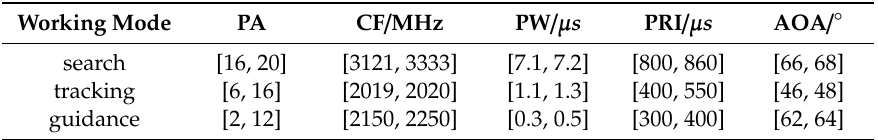
Table 1. Conventional radar characteristic parameters.